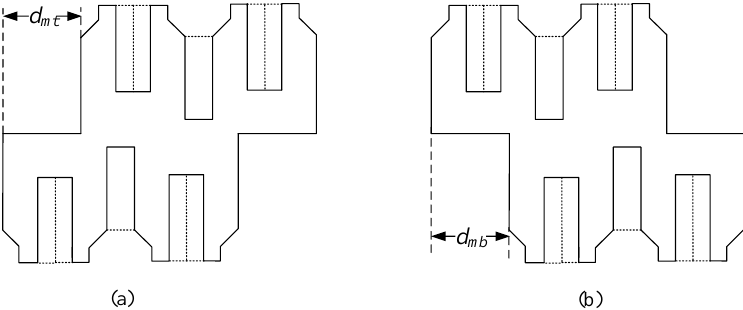
Figure 5. Mover slot displacement variables: ( a ) Top mover slot displacement; ( b ) Bottom mover slot displacement.